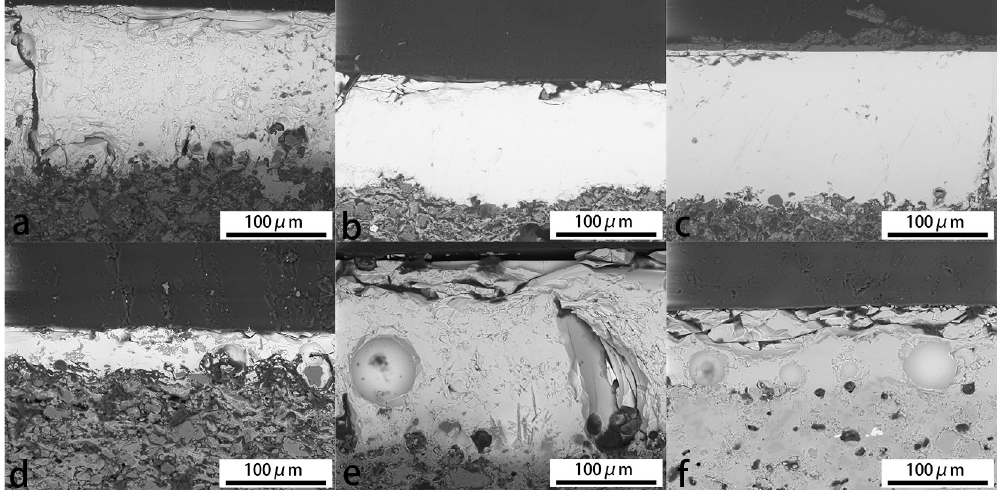
Fig 3. SEM images of samples glaze layers (500X). (a) The sample No. 02. (b) The sample No. 14. (c) The sample No. 23. (d) The sample No. 04. (e) The sample No.24. (f) The sample